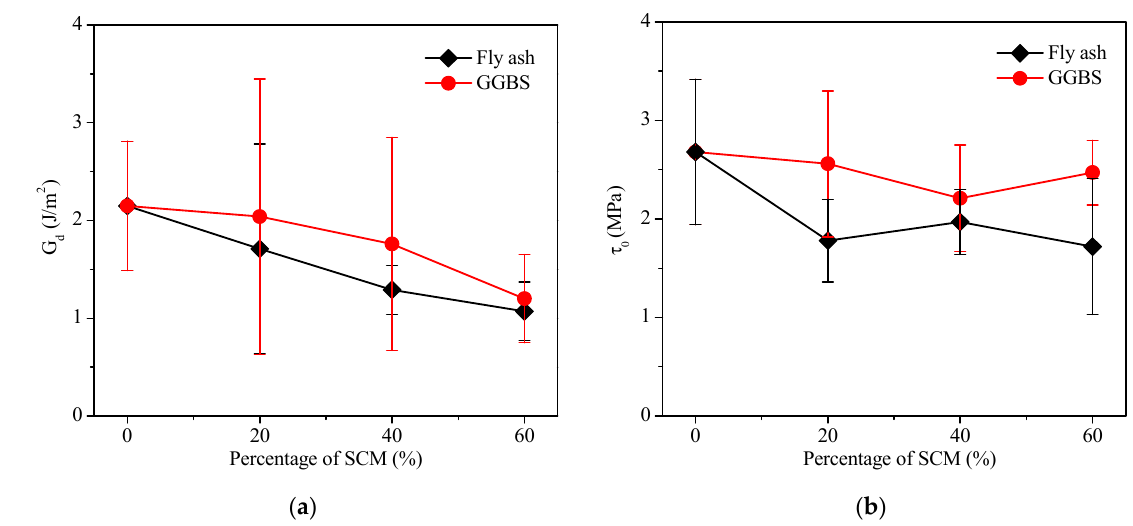
Figure 14. ( a ) Chemical bond strength, G d and ( b ) frictional bond strength, τ 0 as a function of dosage of SCM.